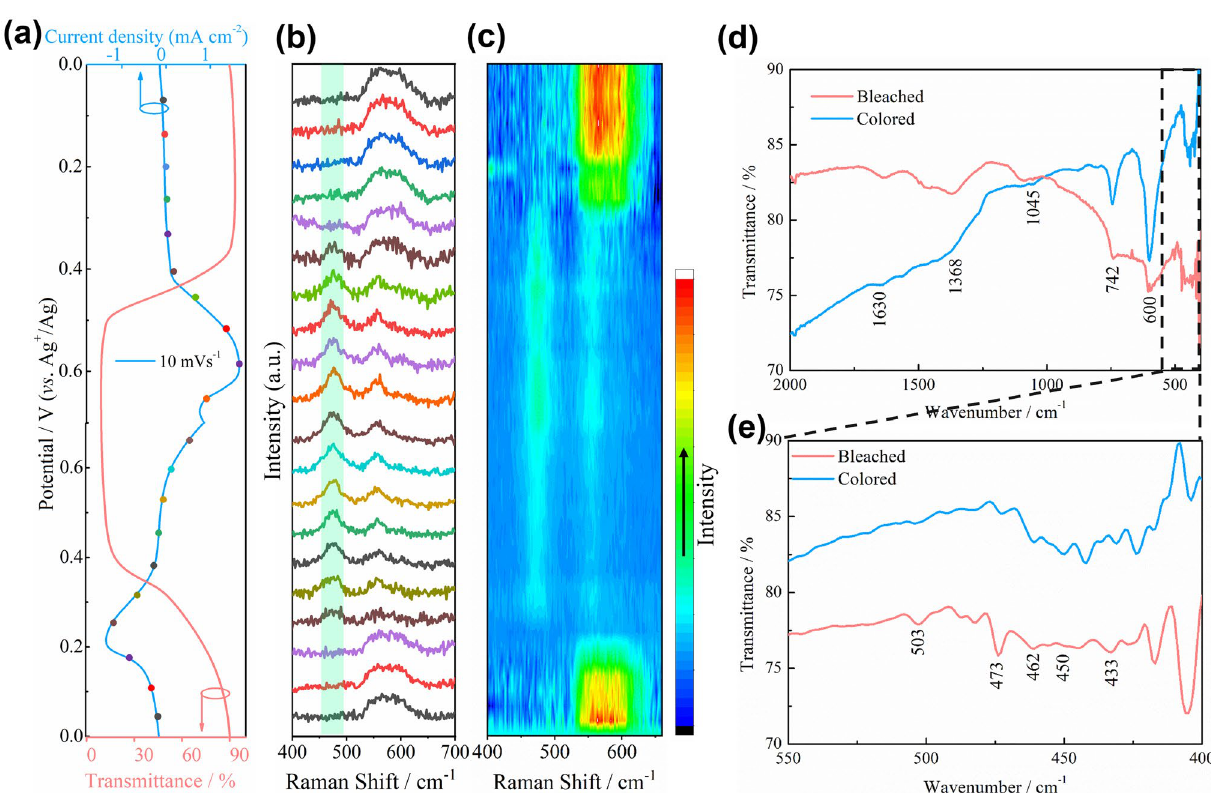
Fig. 4 a CV curve at 10 mV s −1 in 1 M KOH electrolyte and in situ transmittance spectrum at 500 nm of the NHP film. b In situ Raman signal evolution and c chromaticity diagram of NHP film corresponding to the CV curve at 10 mV s −1 . d, e Ex situ FTIR spectra of the colored and bleached NHP